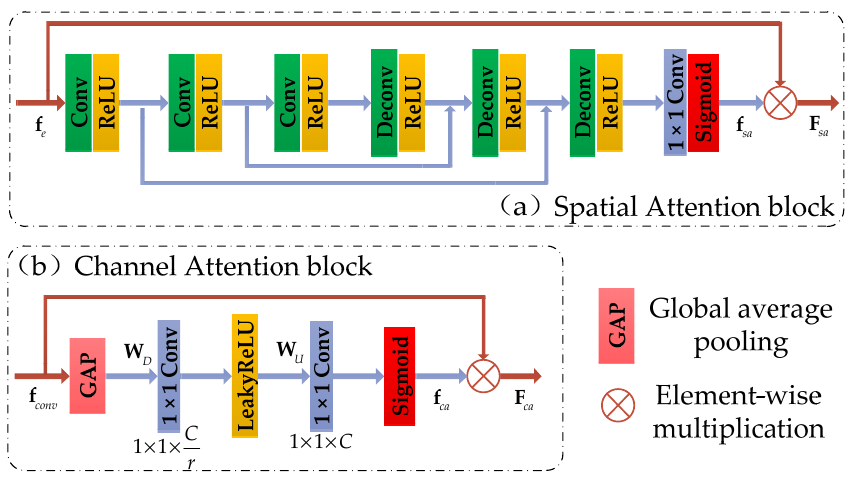
Figure 3. The space attention block and channel attention block in the DSCA